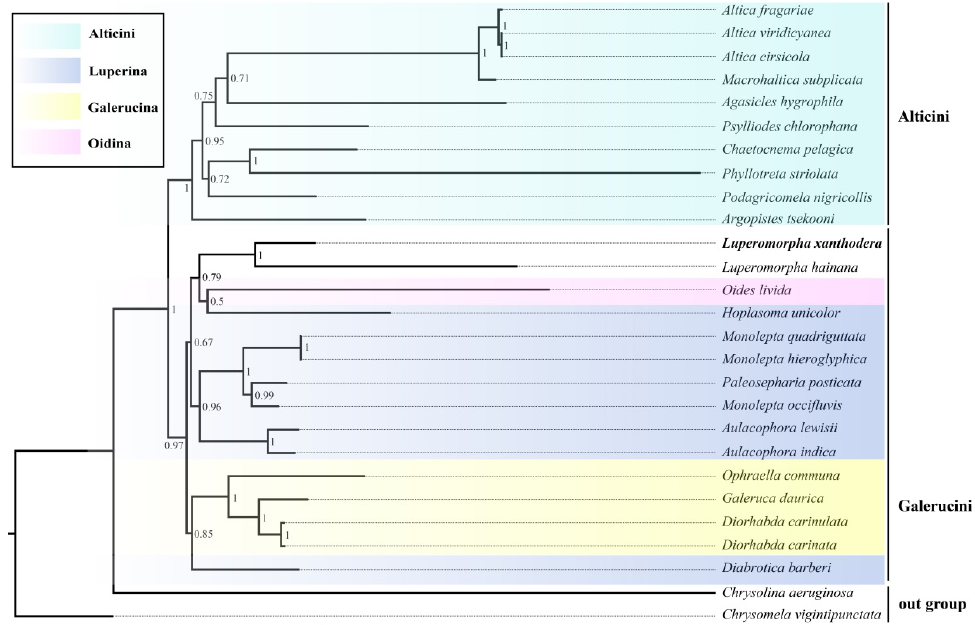
Figure 7. xxx Figure 7. BI analysis was conducted using PhyloBayes with the dataset of amino acids of 13 PCGs. Note: Name in black bold show the phylogenetic position of Luperomorpha xanthodera that we sequenced in this research. The numbers on the nodes are the posterior